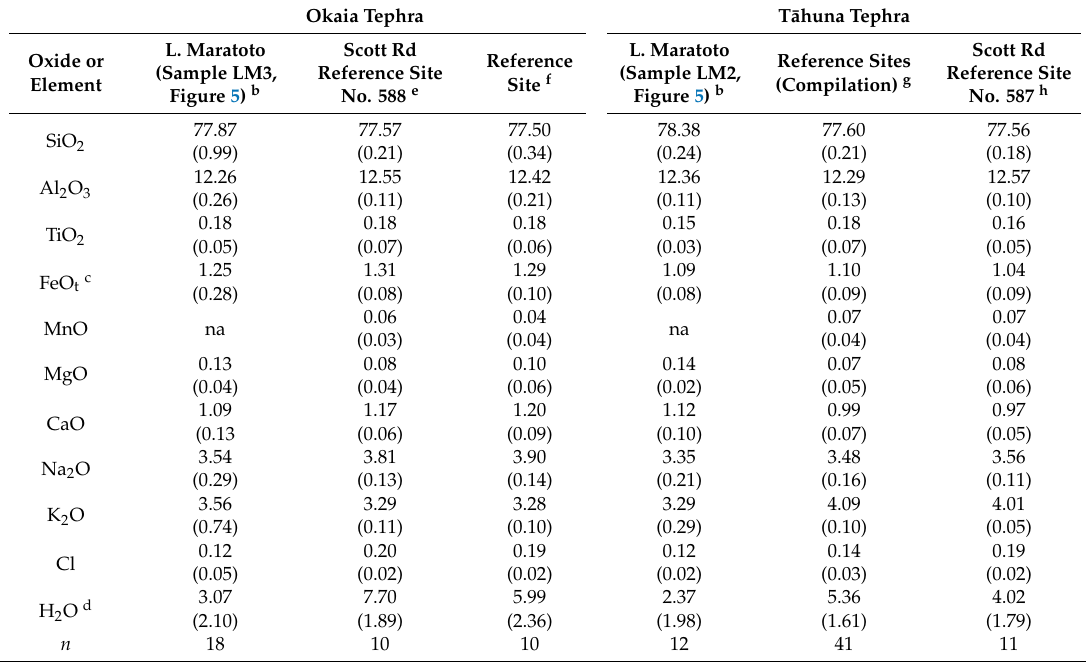
Table 1. Major element compositions a of glass shards of Okaia and T¯ahuna